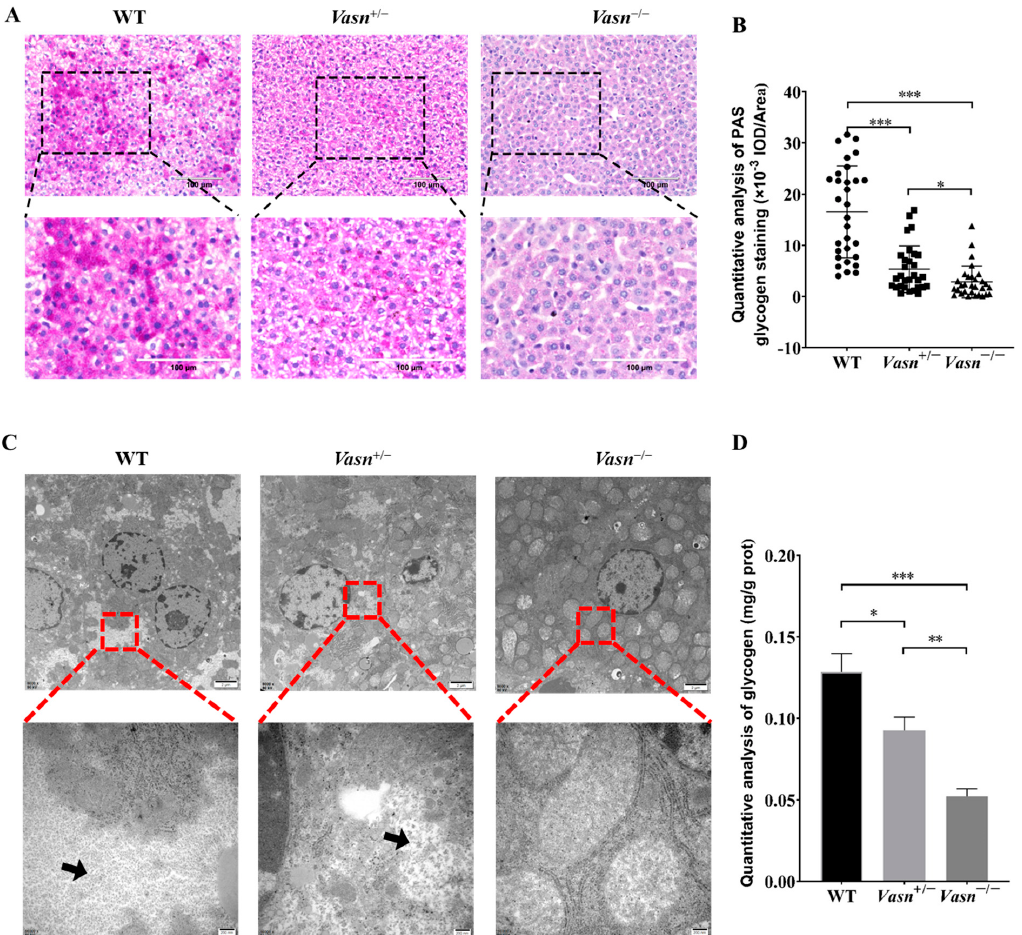
Figure 3. The glycogen content decreased significantly in Vasn − / − and Vasn +/ − mice. ( A ) Periodic acid Schiff (PAS) staining detected the presence of glycogen in liver tissues of Vasn − / − , Vasn +/ − , and WT mice at 3 weeks of age. ( B ) Quantitative IOD analysis of the PAS staining area. ( C ) TEM observation of glycogen in liver tissues of Vasn − / − , Vasn +/ − , and WT mice at 3 weeks of age; black arrows show glycogen particles. ( D ) Quantitative analysis of the glycogen content; data are expressed as mean ± SD of three independent experiments. * p < 0.05, ** p < 0.01, *** p < 0.001.